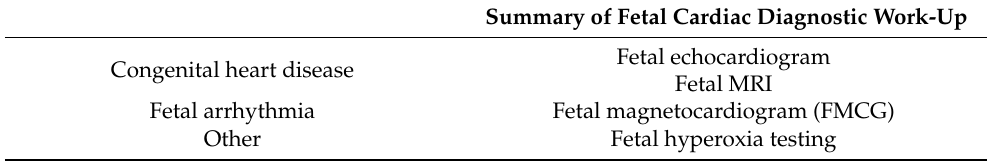
Table 2. An overview of fetal cardiac diagnostic work-up. Summary of Fetal Cardiac Diagnostic Work-Up Fetal Congenital heart disease